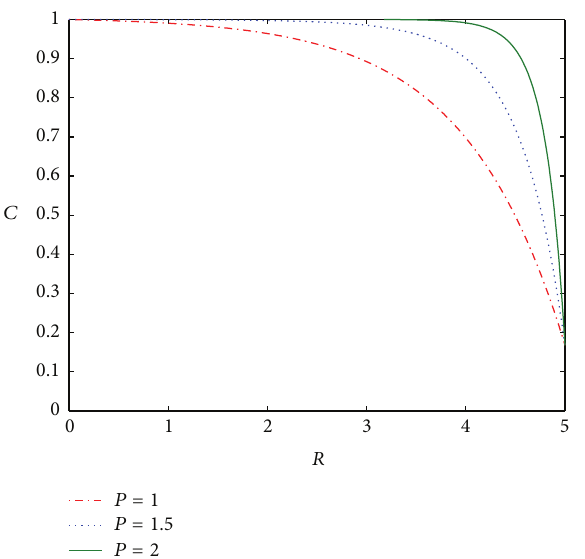
Figure 6: Steady contaminant profile for concentration given in (37). Here 𝑅 = 𝑅 𝑎 = 2 .